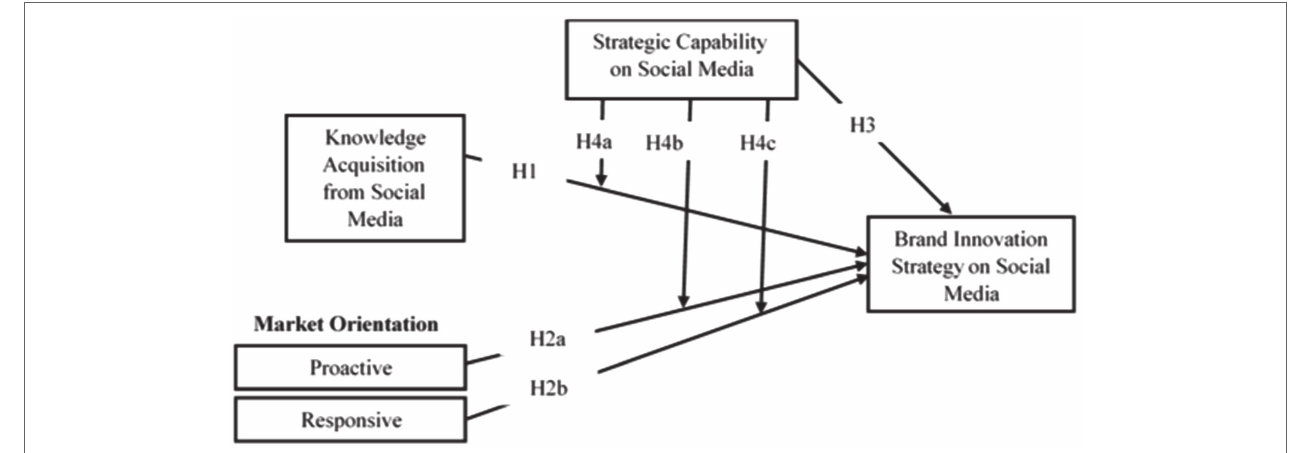
FIGURE 1 | Conceptual